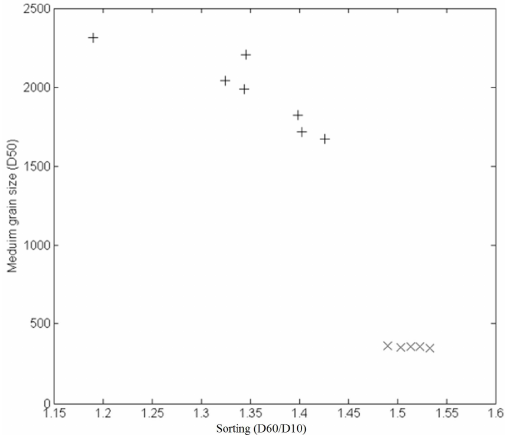
Figure 8. Grain size distributions for the shell fragments ( + ) and medium grain sand ( × ).